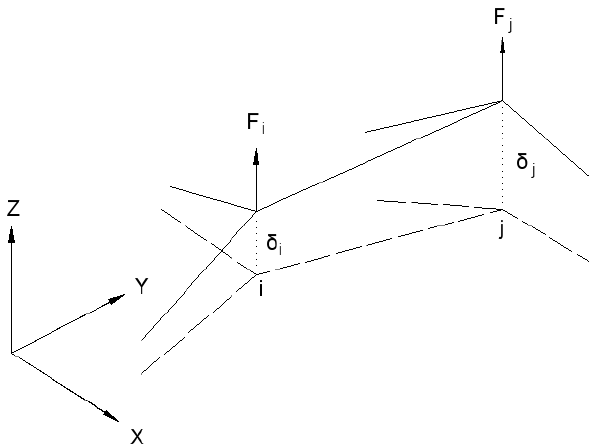
Figure 2: Reference geometrical scheme for the semi-analytical formulation (unloaded structure is shown by dotted lines, deformed structure by continuous lines)